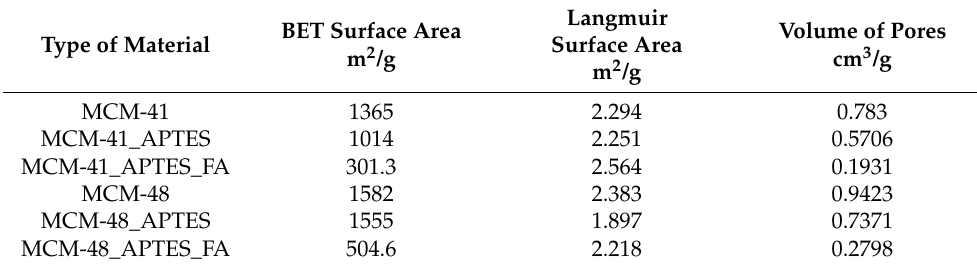
Table 2. BET characteristics of mesoporous